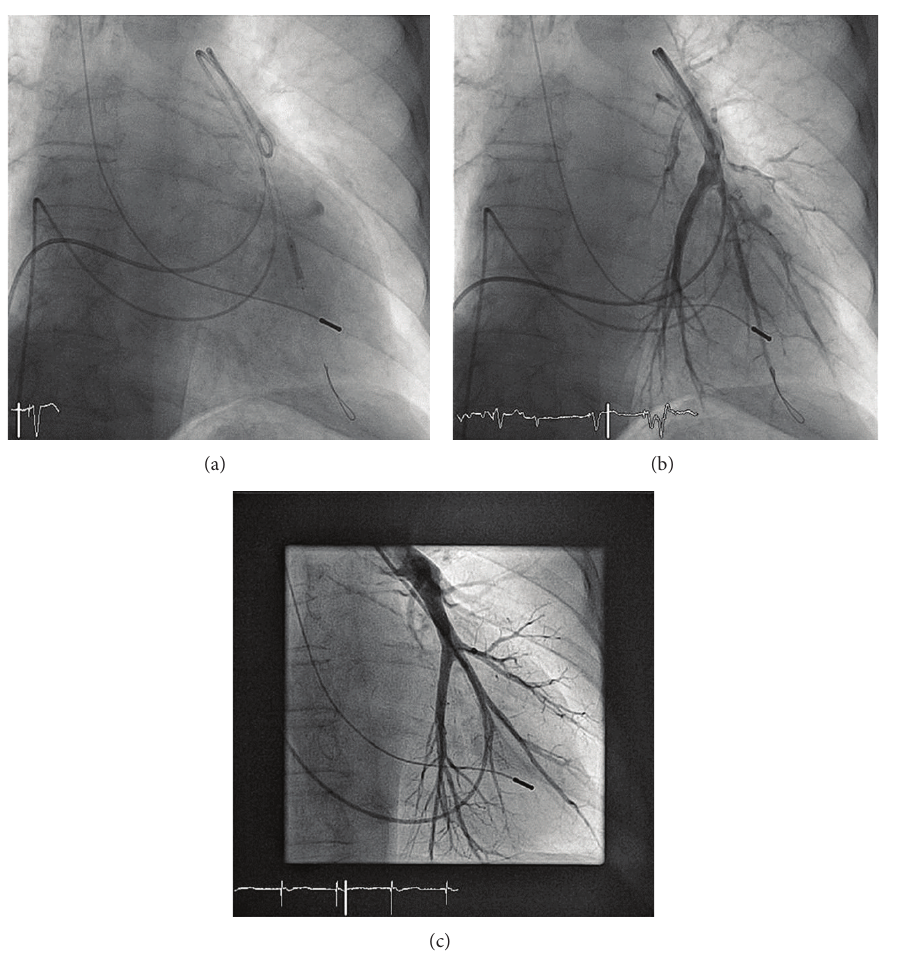
Figure 2: Stent graft implantation for the treatment of pulmonary artery false aneurysm. (a) False aneurysm was treated by the implantation of two coronary stent grafts to exclude the false aneurysm from the pulmonary artery. (b) Pulmonary angiography showed excellent result with unrestricted blood flow into the periphery while bleeding was stopped. (c) After 3 months there was a completely thrombotic false aneurysm without extravasation of contrast media. The pulmonary artery was obstructed at the level of the implanted stent